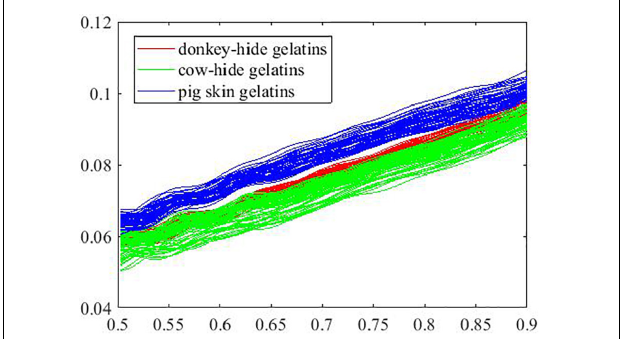
set that separates samples in different groups with no error.